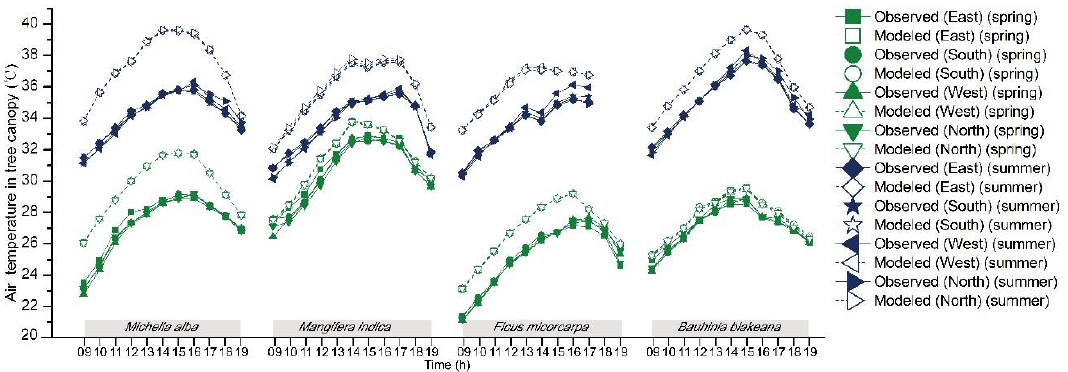
Figure 10. Comparison of modeled and observed air temperatures in tree crown for four directions.